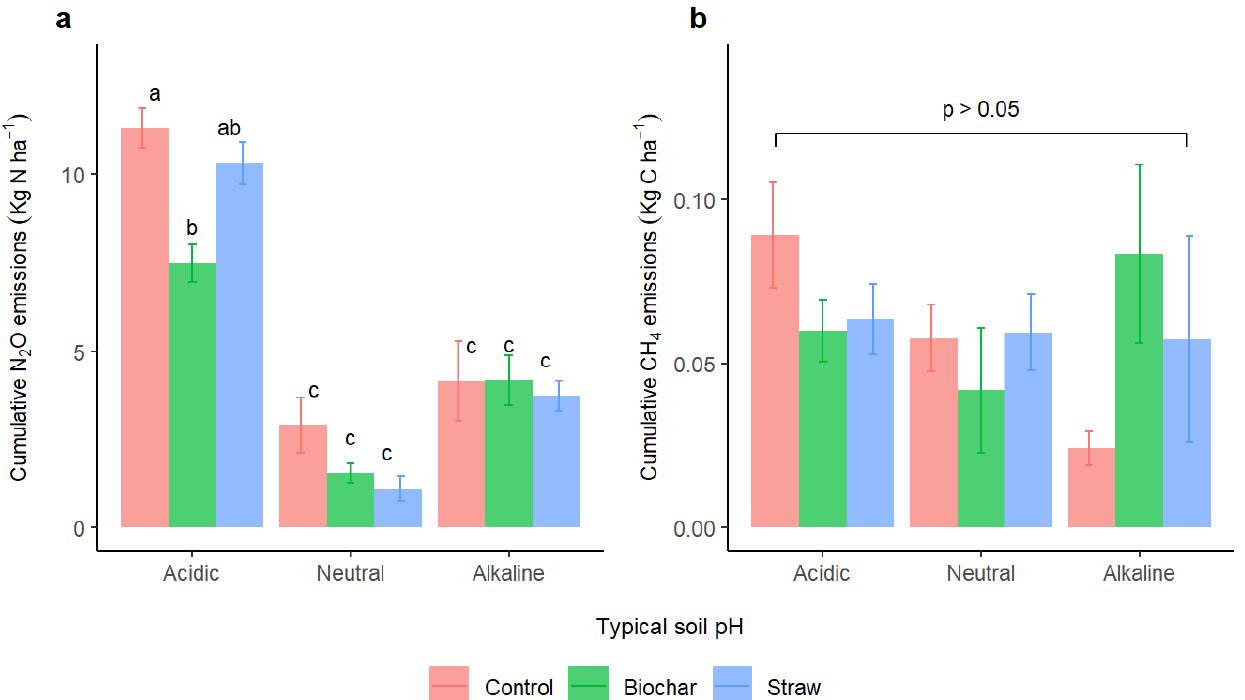
Figure 5. Cumulative emissions of ( a ) N 2 O and ( b ) CH 4 for soils with different pH in response to biochar and straw. The error bars indicate the standard error of the mean, and means that do not share any letter among a, b and c in ( a ) are significant different at the 5% level of significance, adjusted by the Tukey test. The segment above the error bars in ( b ) indicates that the study was not precise enough to see any significant difference among the sample means; hence, the data were not surprising, considering the null hypothesis is true.